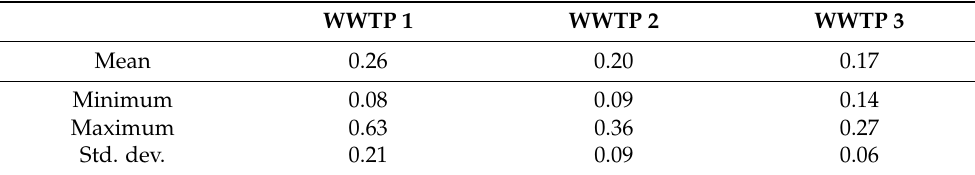
Table 5. Basic statistic of Biodegradability Index.